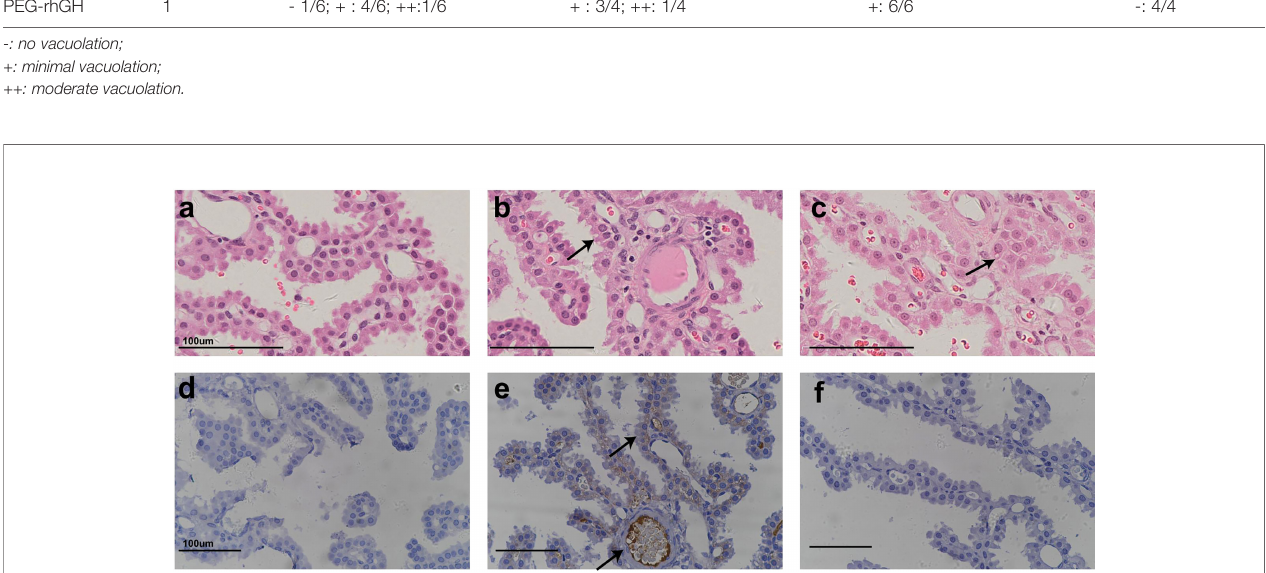
FIGURE 1 | H&E staining and IHC staining of cynomolgus monkeys CP epithelium with 26-week administration of Jintrolong. (A) Excipient control group with 26-week administration. (B) Jintrolong group with 1 mg/kg/week administration for 26 weeks. (C) Jintrolong recovery group with 1 mg/kg/week administration for 26 weeks and following recovery period of 26 weeks. (D) anti-PEG IHC stain of control group. (E) anti-PEG IHC stain of Jintrolong group with 26 weeks of administration. (F) anti-PEG IHC stain of Jintrolong group after recovery. Arrows in (B, C) indicate cytoplasmic vacuoles in CP epithelium. Arrows in (E) indicate representative anti-PEG staining. Black line: under dose 3mg/kg/week; blue line: under dose 1mg/kg/week; red line: under dose 0. 3mg/kg/week; Dotted line: predicted threshold dose to induce vacuolation.